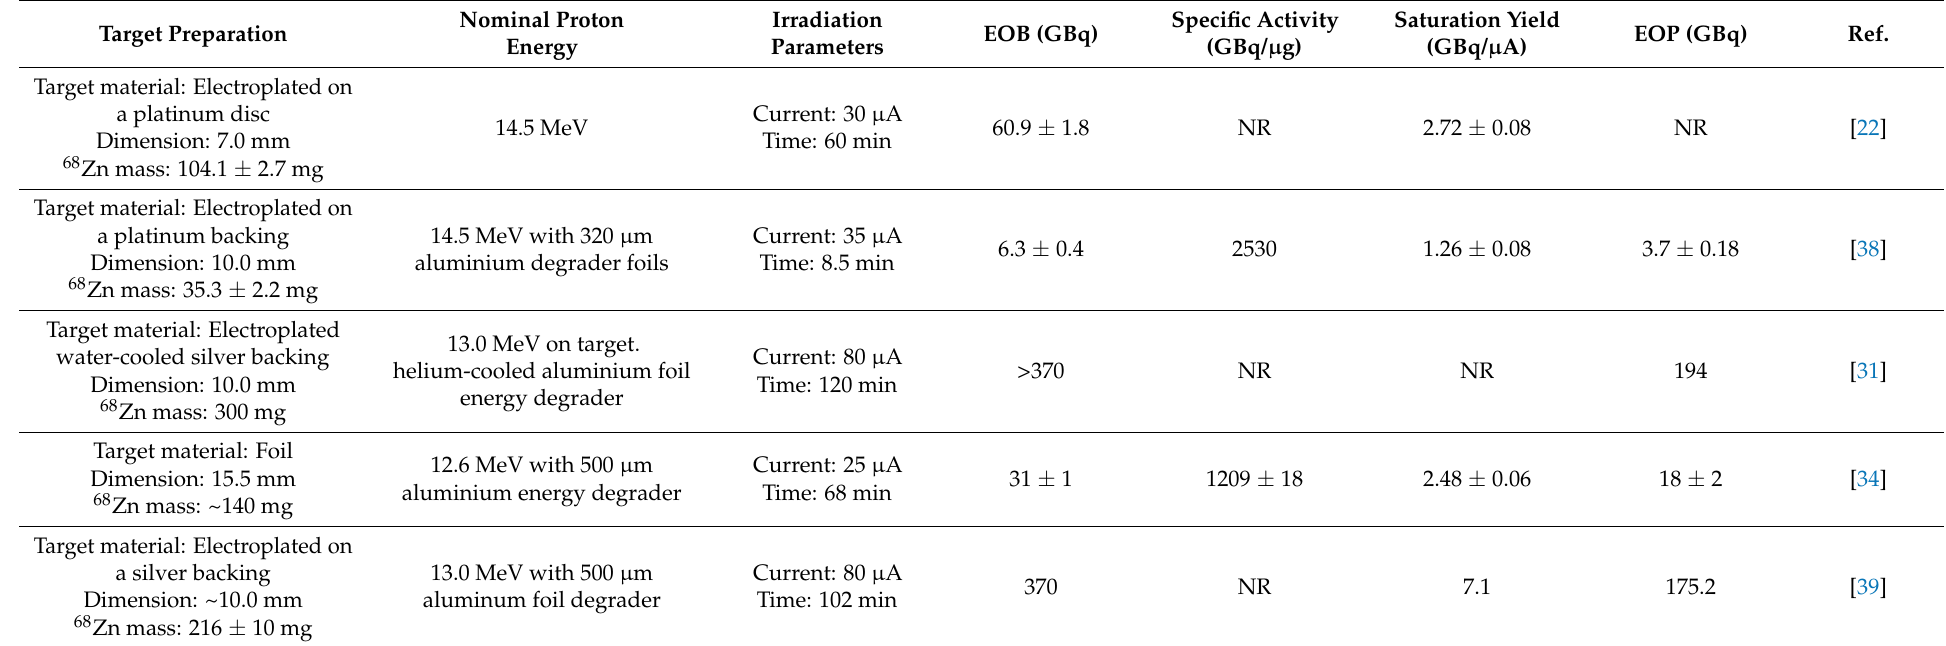
Table 1. 68 Ga production with PETtrace Cyclotron with 68 Zn irradiation. Included yield activity at EOB and